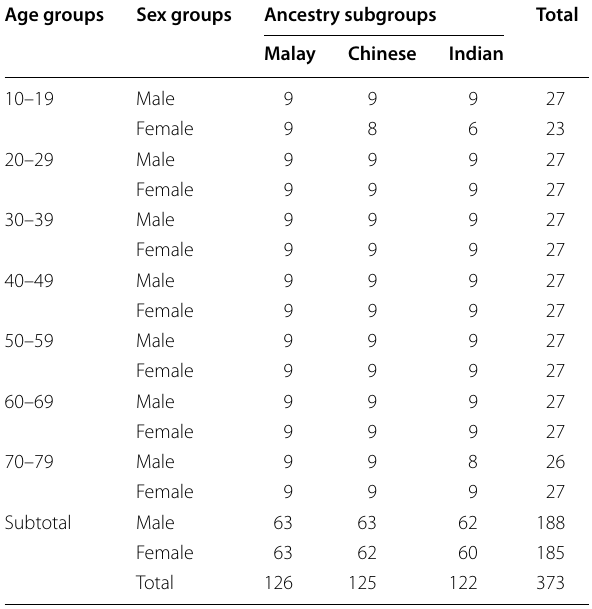
Table 1 Subject distribution across sex, age and ancestry subgroups